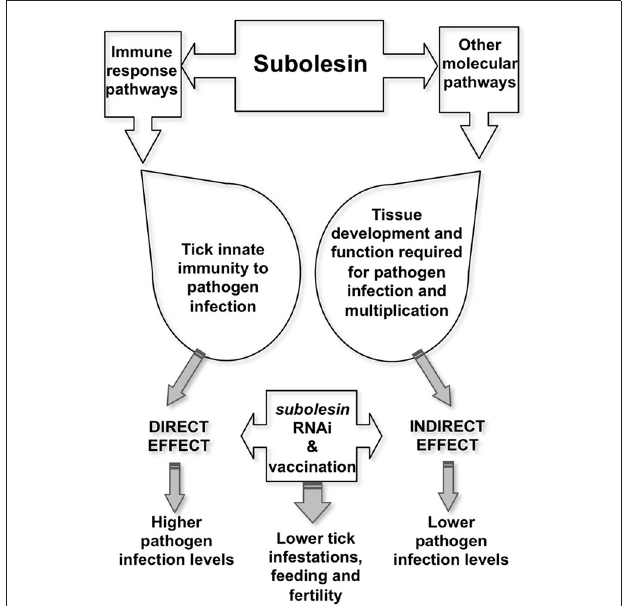
FIGURE 2 | Model for Subolesin role in pathogen infection. Targeting SUB by vaccination or RNAi reduces tick immunity, thereby increasing pathogen infection levels. However, lower pathogen infection levels may result from the effect on tissue structure and function and the expression of genes that are important for pathogen infection and multiplication. Both direct and indirect effects of targeting SUB results in lower tick infestations, feeding and